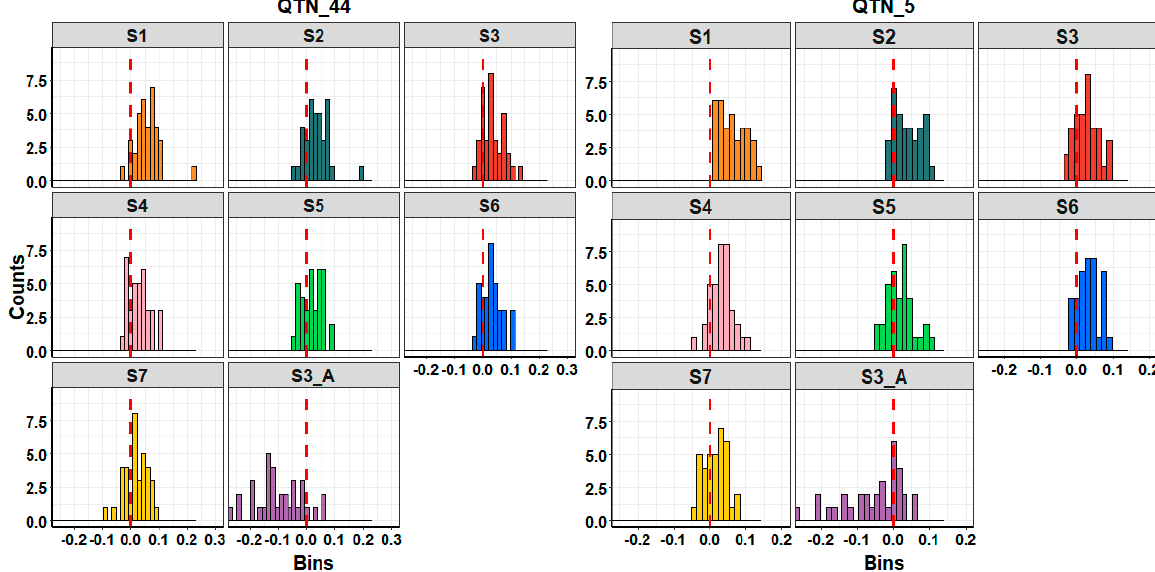
Figure 5. Histograms of each scenario representing the differences between accuracy from genomic predictions (ssGBLUP) versus genetic prediction (BLUP) per simulation. Right-sides of red dashed lines represent the number of simulations in which genomic selection outperformed BLUP.